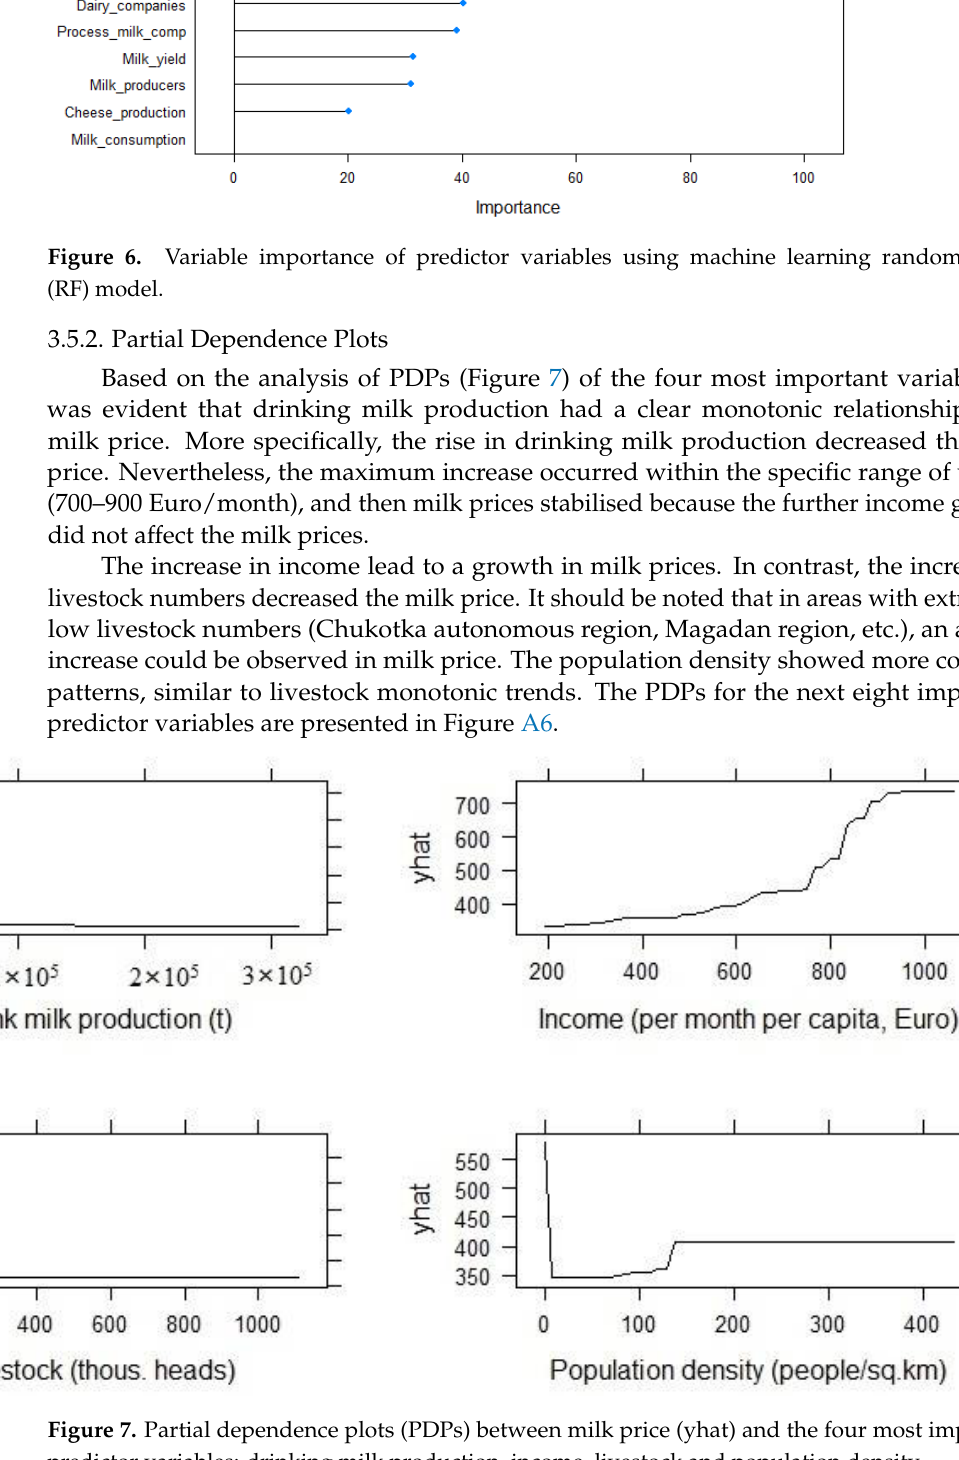
Figure 7. Partial dependence plots (PDPs) between milk price (yhat) and the four most important predictor variables: drinking milk production, income, livestock and population